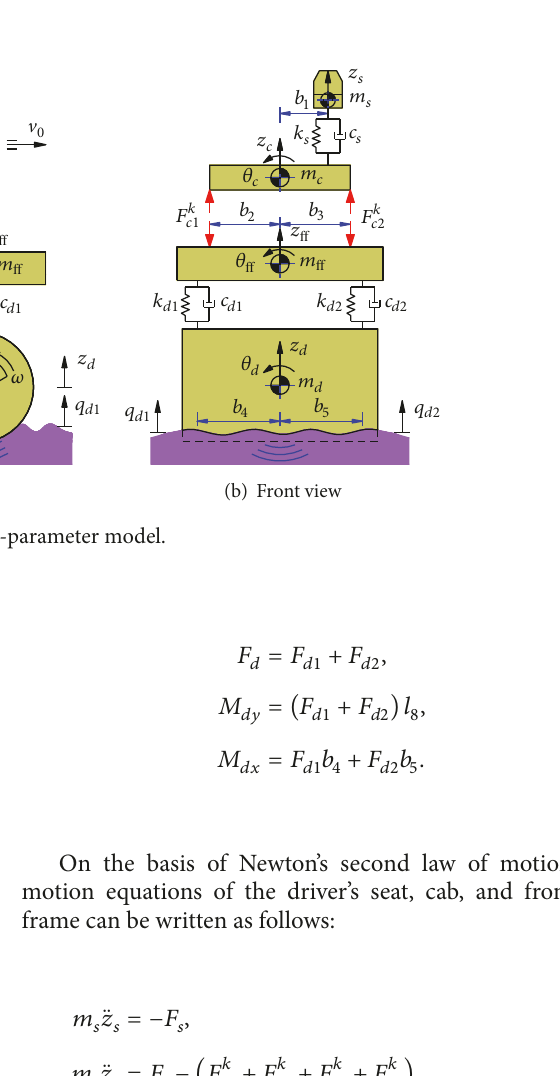
Figure 1: Schematic of vibratory roller with three different cab’s isolation mounts.